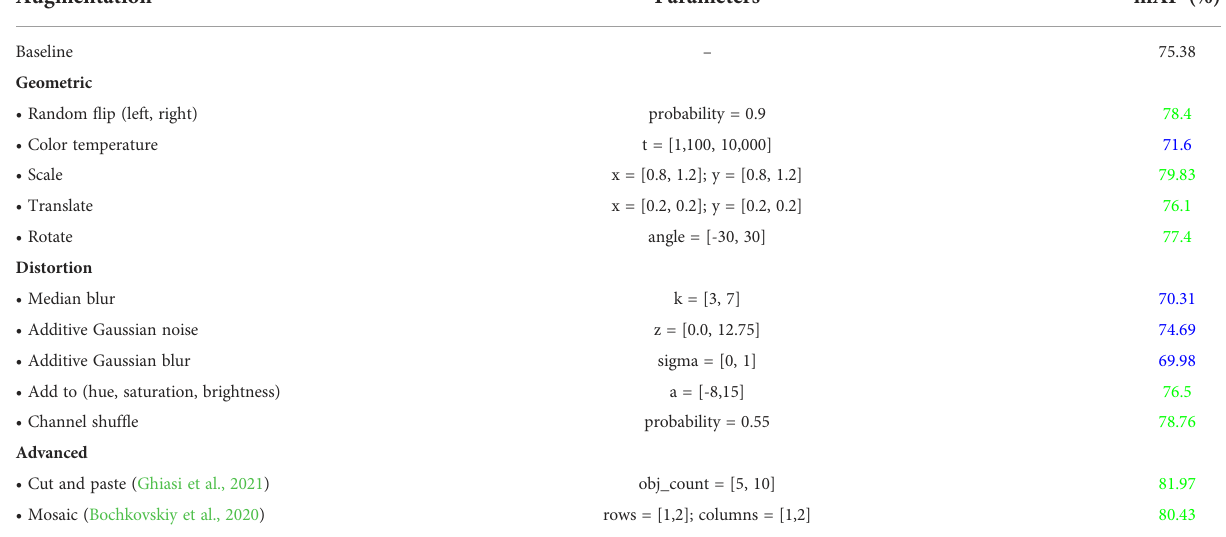
TABLE 4 Effect of data augmentation on the performance of the DDL unit.